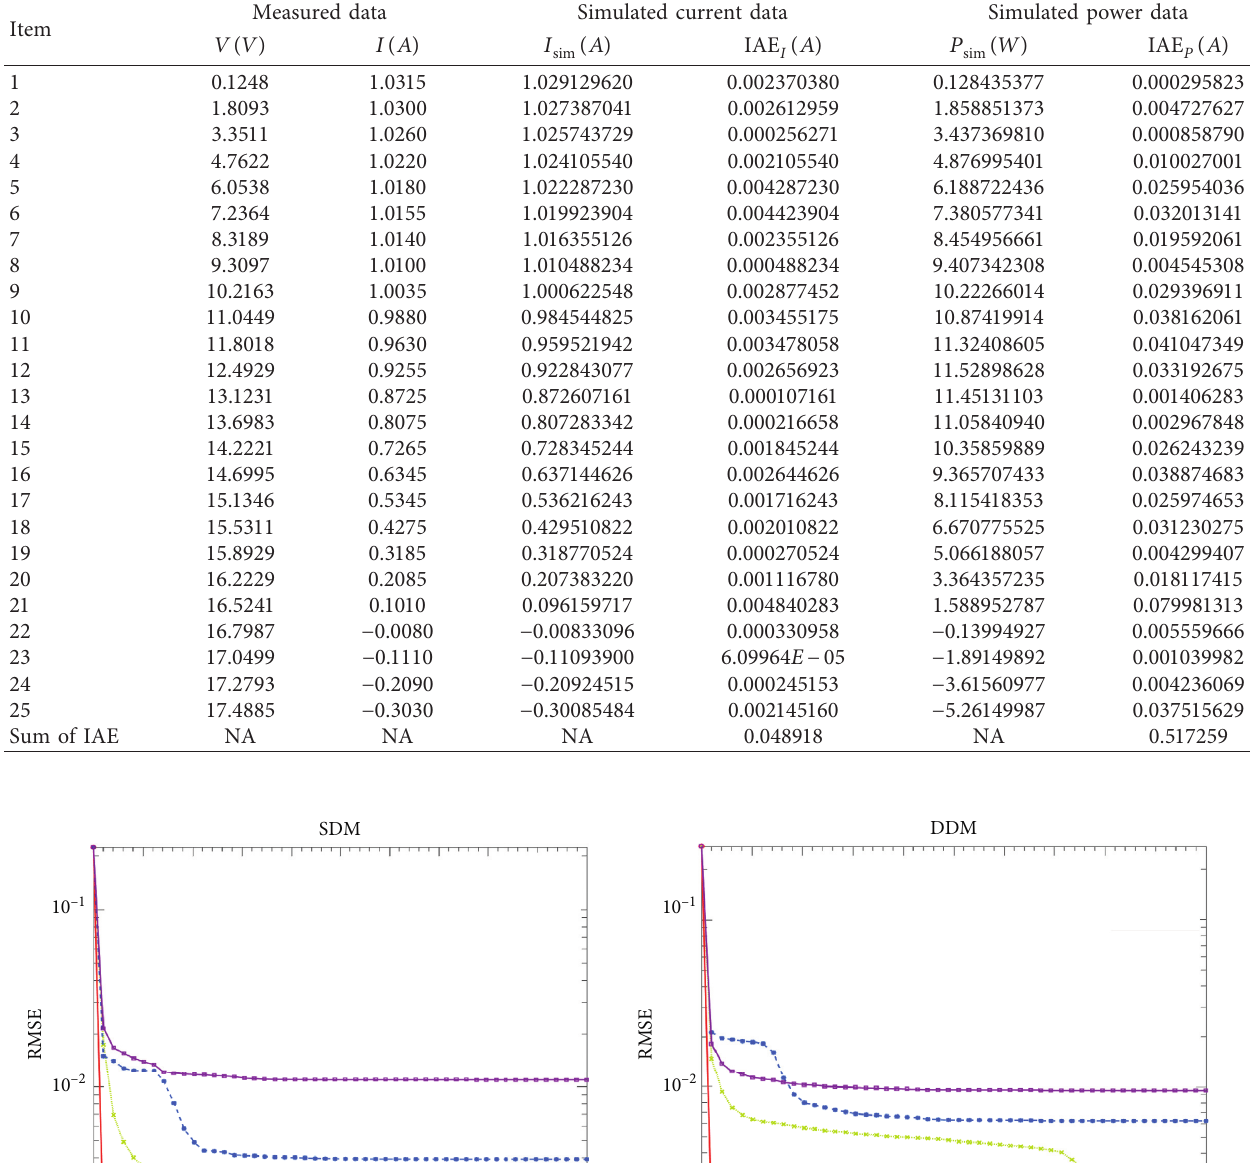
Table 7: Simulated data and associated IAE obtained by MWAO on PV module model.